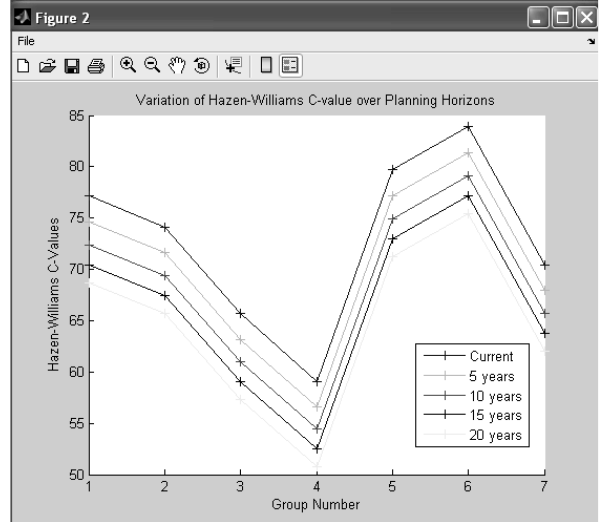
Figure 17. Variation of Hazen-William C-values for di ff erent Fig. 17. Variation of Hazen-William C-values for different groups